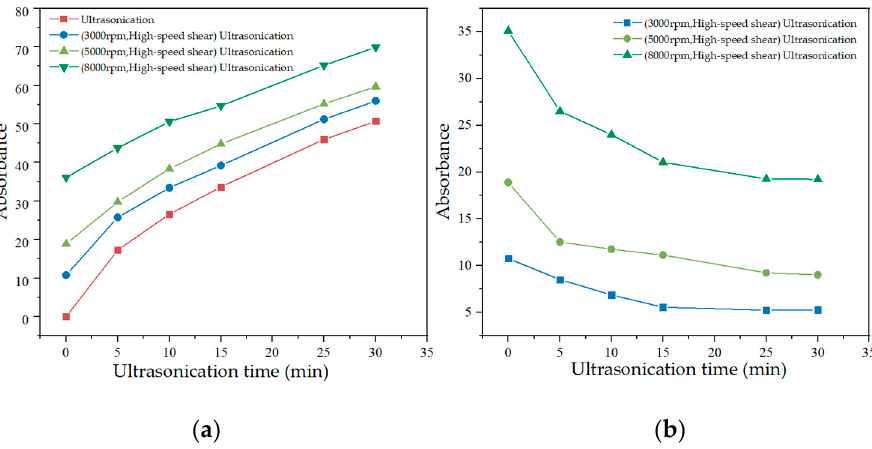
Figure 7. ( a ) A comparison between the absorbance of GNPs suspension under ultrasonication with and without high-speed shear; ( b ) The difference value between the absorbance of GNPs suspension under ultrasonication with and without high-speed shear.